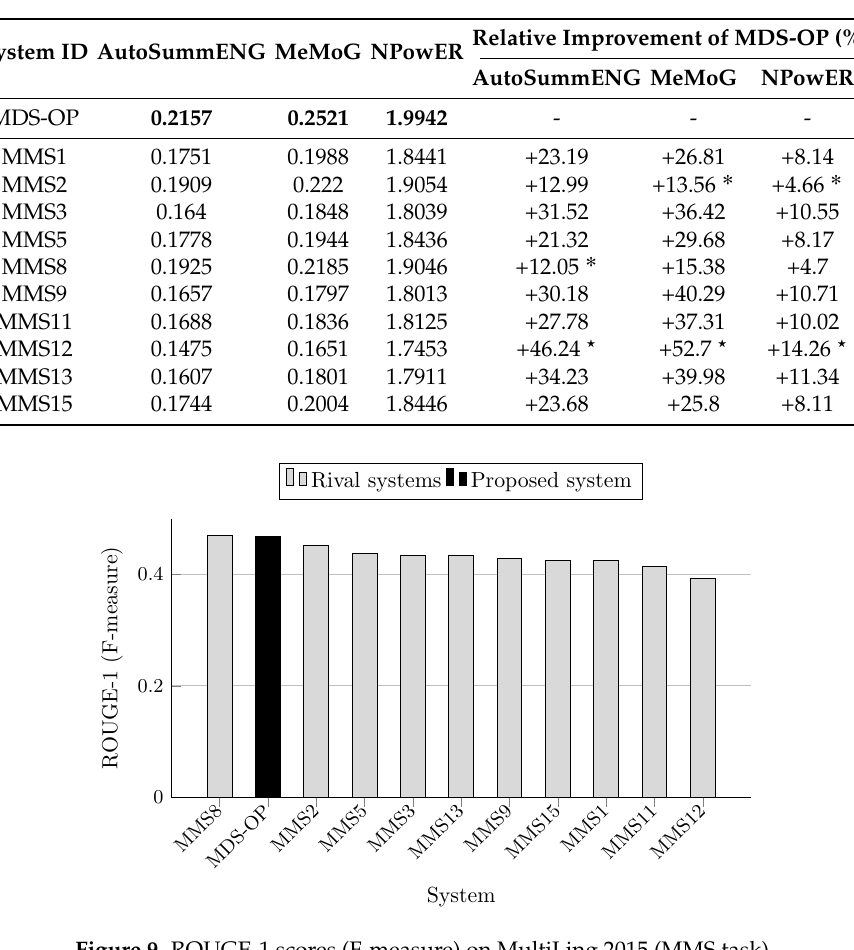
Table 6. Scores of MDS-OP and the participating systems on MultiLing 2015 (MMS task) obtained with evaluation methods AutoSummENG, MeMoG, and NPowER. The highest values are written in bold. The highest and the lowest improvements (%) of MDS-OP are indicated by ‹ and ˚ , respectively.